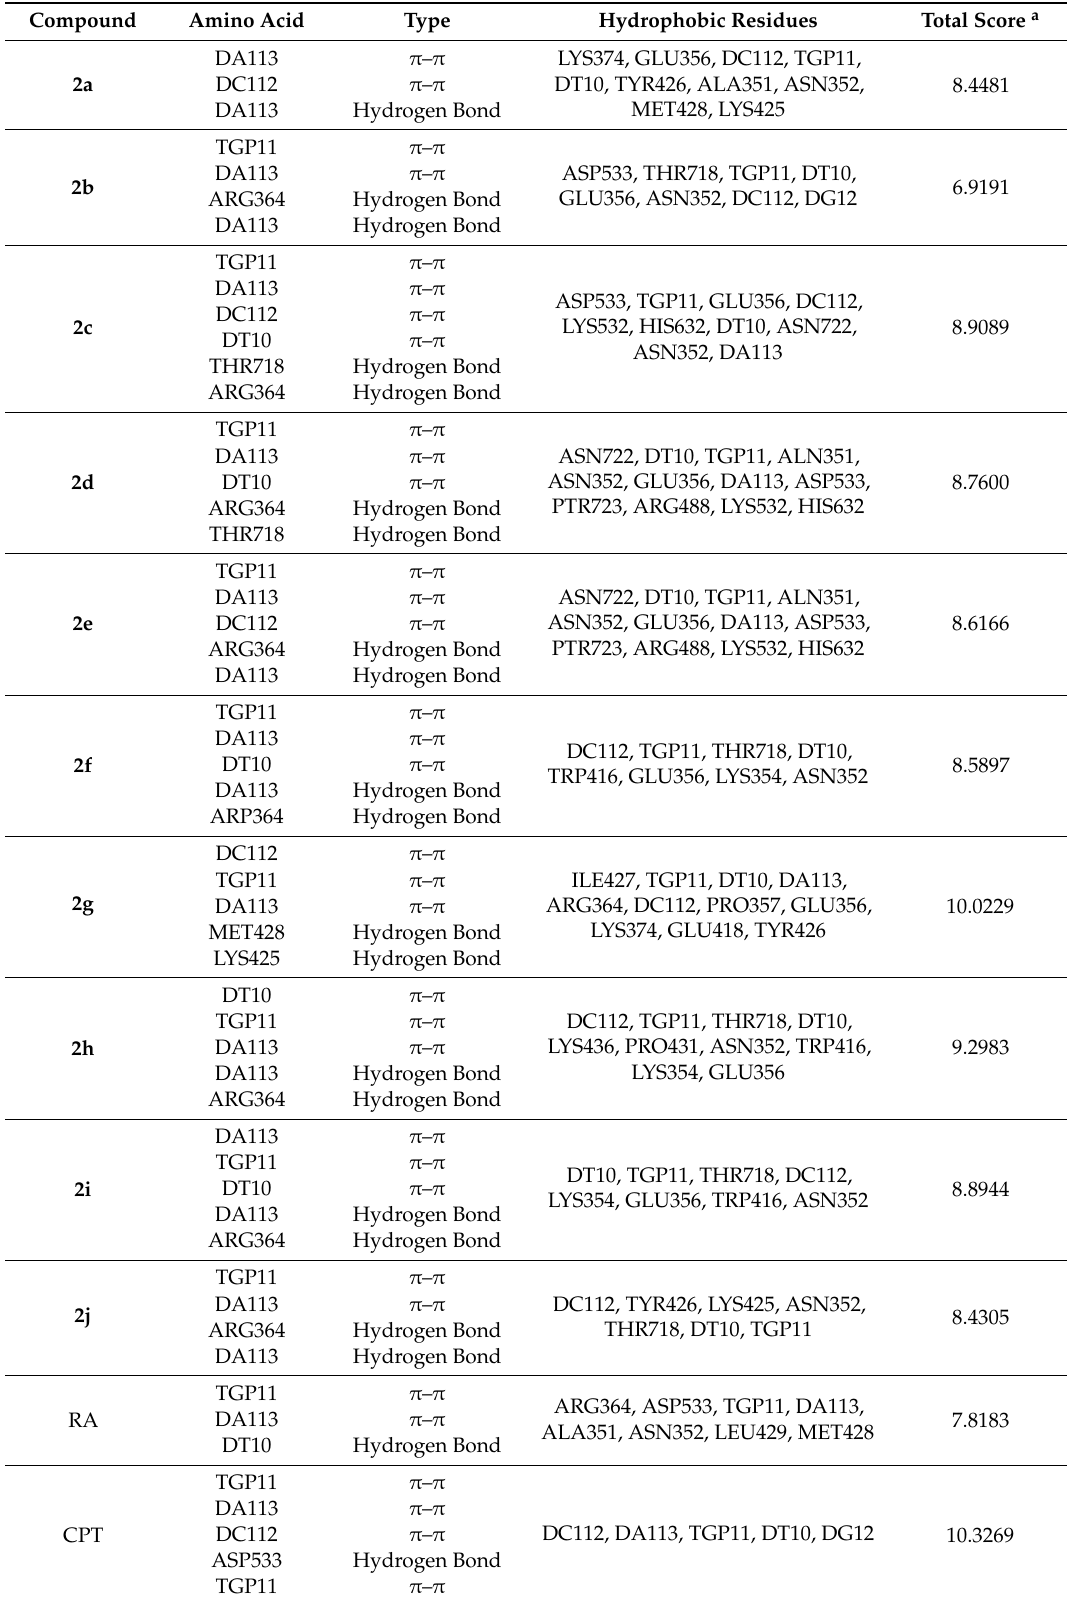
Table 2. Interactions between DNA Topo I (from PDB ID 1T8I) and target